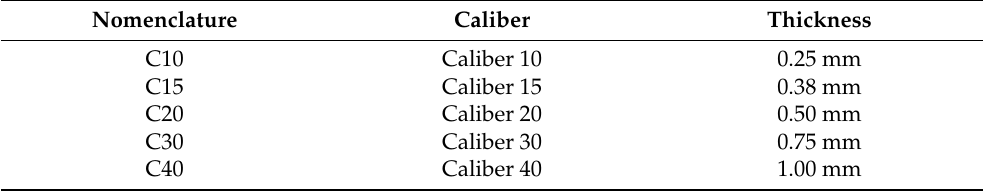
Table 1. Nomenclature, caliber, and thickness of the five styrene plastic stripes used in this study for making the flexure